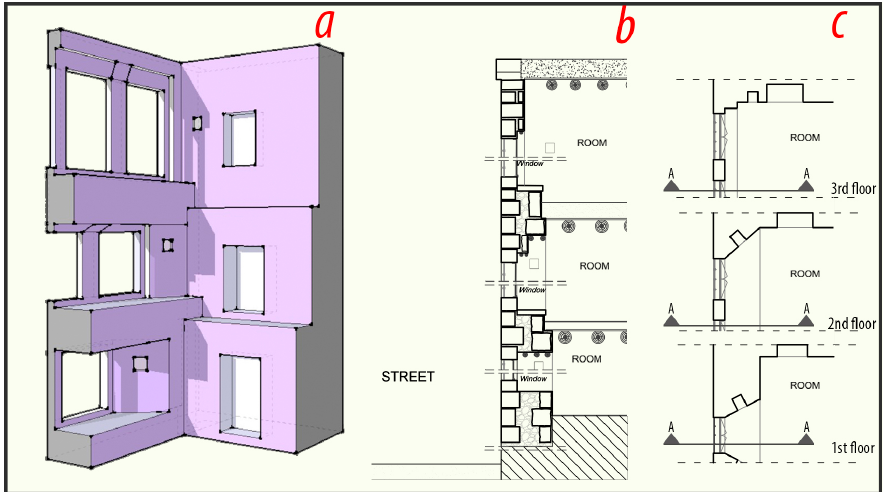
Figure 3. Wall detail: ( a ) Model of a 3-storey building, ( b ) Section, ( c ) Plans.